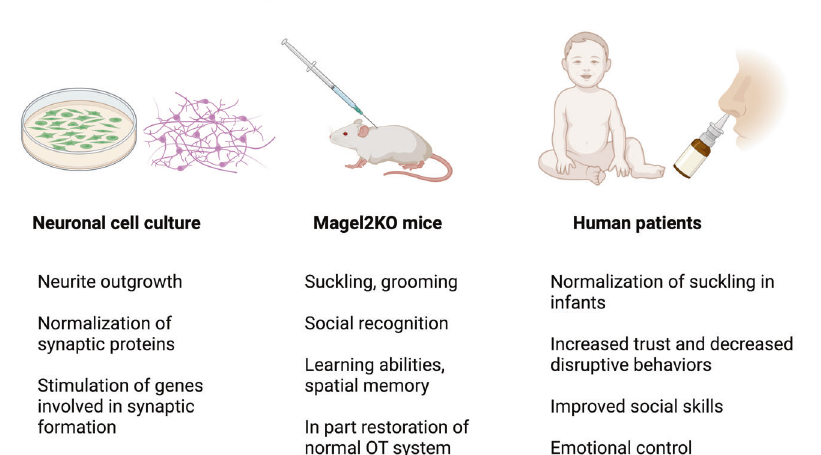
Fig. 2 Effects of oxytocin treatment on symptoms in PWS and SYS models. List of features and symptoms that were rescued by OT administration in neuronal cell culture, mouse models, and PWS